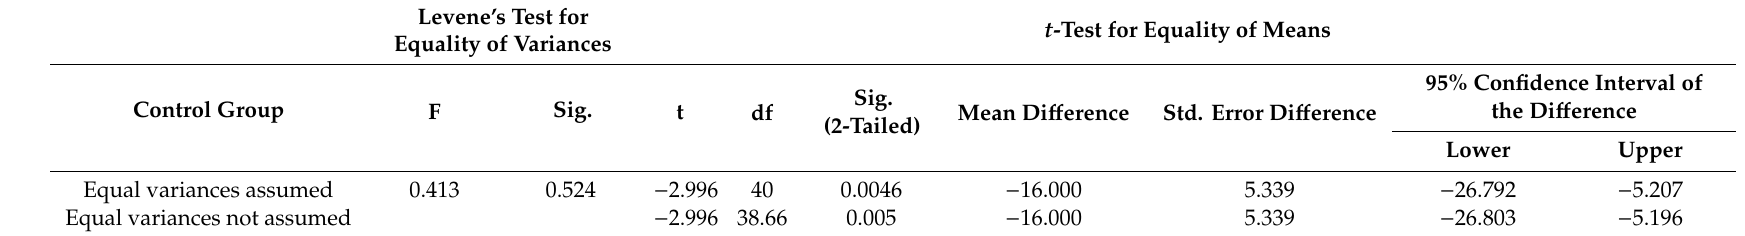
Table 7. Independent sample t-test (pre-test–post-test) control